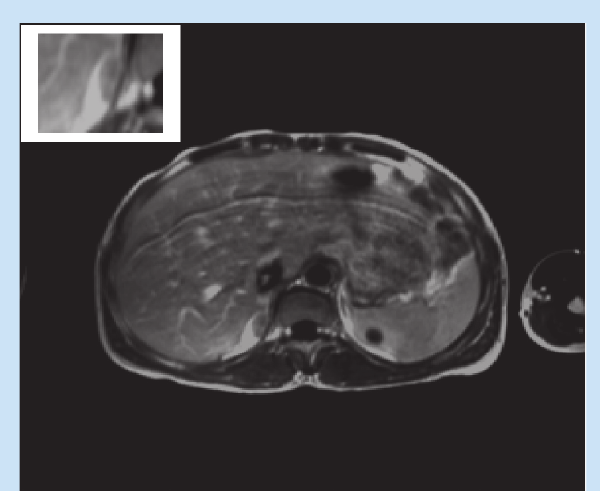
Fig. 3. The post-gadolinium T1 weighted (TR 525/TE 13) axial MRI demonstrates contrast enhancement of the mass easily visualised in the right adrenal gland. There is an incidental simple cyst in the left kidney. The left adrenal gland is well demonstrated and is normal.